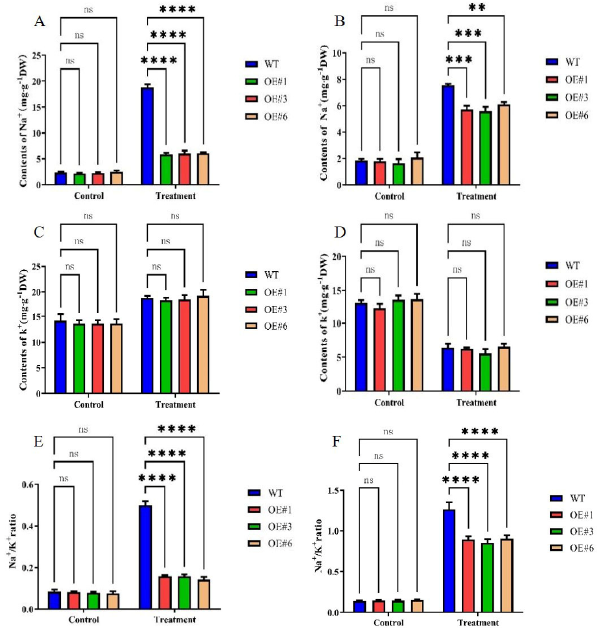
Figure 3. The Na + content of leaves ( A ) and roots ( B ), the K + content of leaves ( C ) and roots ( D ), and the Na + /K + ratio of leaves ( E ) and roots ( F ) of control (0 mM NaCl) and salt ‐ treated (200 mM NaCl) soybean seedling leaves after 36 h. Note: A group–group significance analysis was performed, and each treatment (OE#1, OE#3, and OE#6) was compared to WT. All values are presented as the mean ± SD of three independent experiments. ** p < 0.01, *** p < 0.001, **** p < 0.0001.